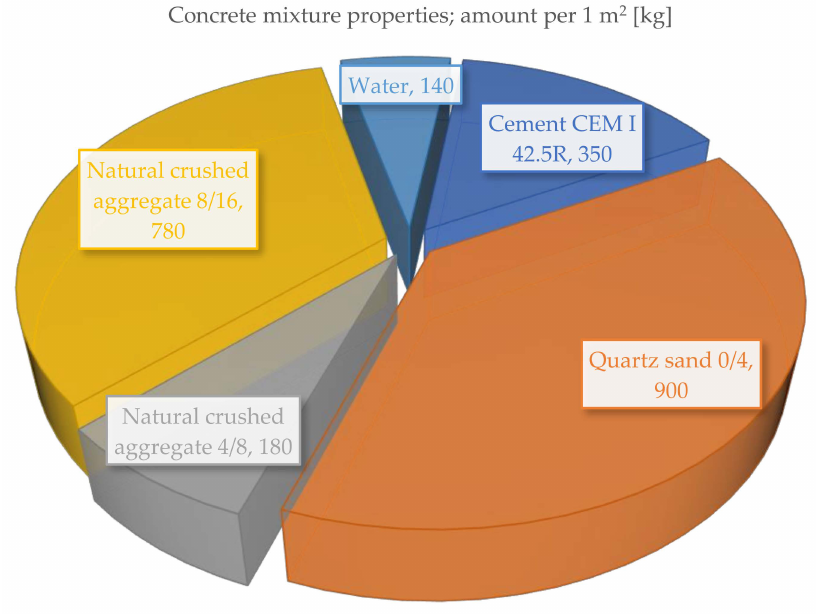
Figure 1. Concrete mixture properties; amount per 1 m 2